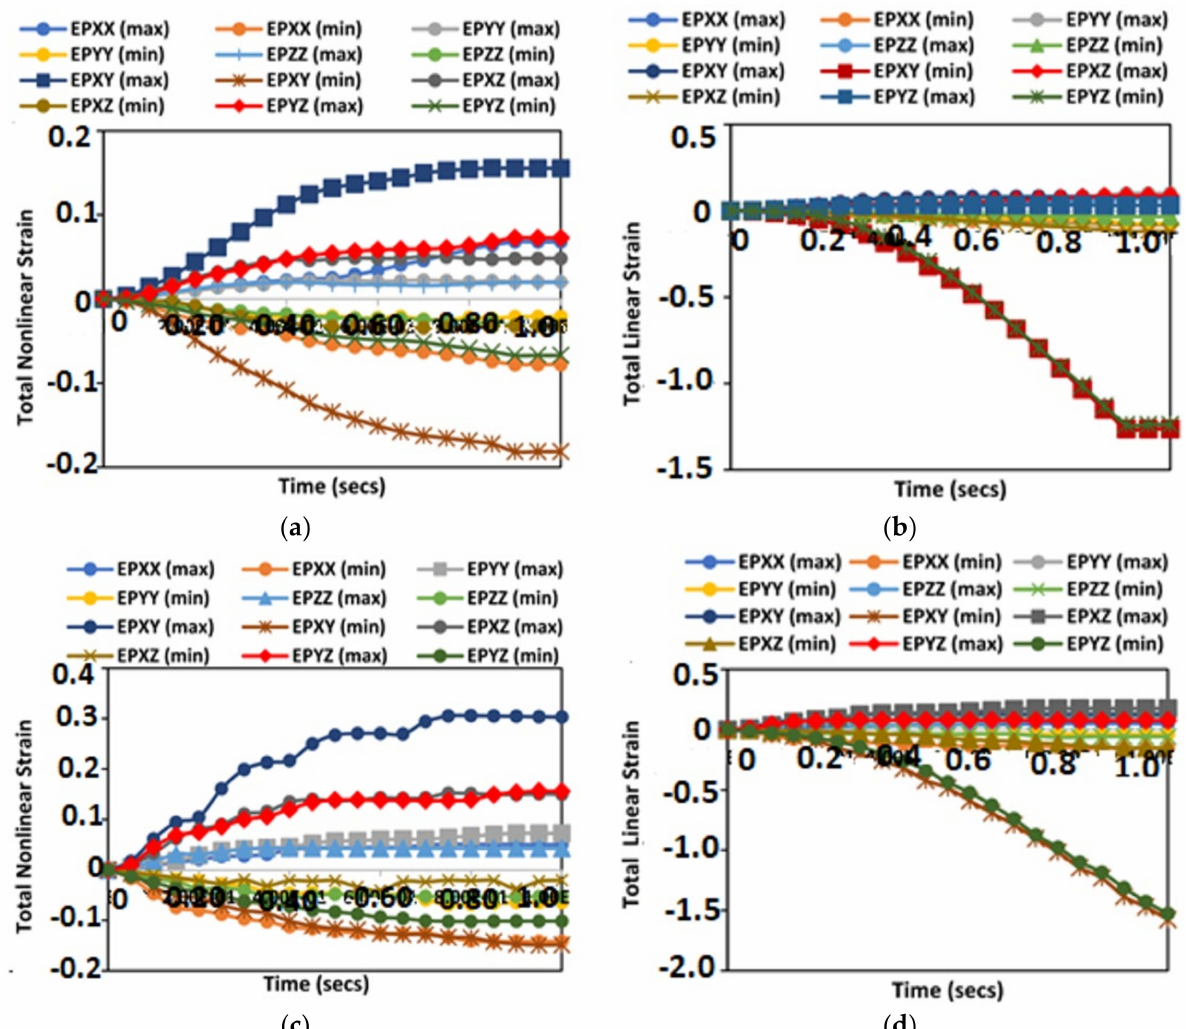
Figure 10. The total strain profiles for the reeling hose Carbon fibre composite model, showing ( a ) total nonlinear strain of carbon fibre linear elastic model, ( b ) total linear strain of carbon fibre linear elastic model, ( c ) total nonlinear strain of carbon fibre elastoplastic model, ( d ) total linear strain of carbon fibre elastoplastic